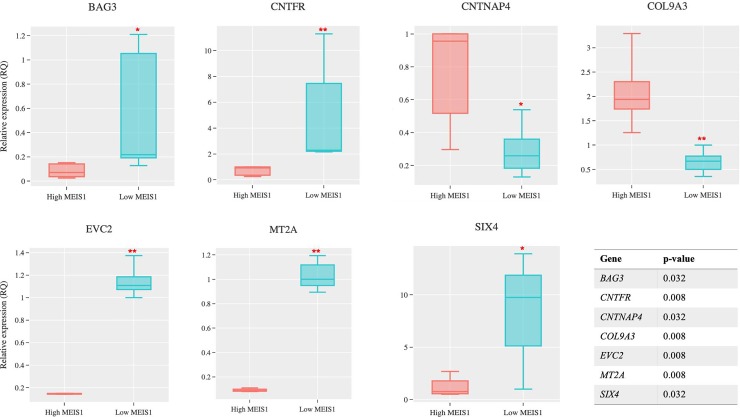
Expression Validation of the DEGs common between cell lines and thalamus by q-RT-PCR and their corresponding p-values.The expression levels of the seven DEGs present in both human cell lines and thalamus (as listed in Table 4) were measured by q-RT-PCR and their differential expression was assessed by non-parametric Wilcoxon test. **p≤0.01; *p≤0.05.